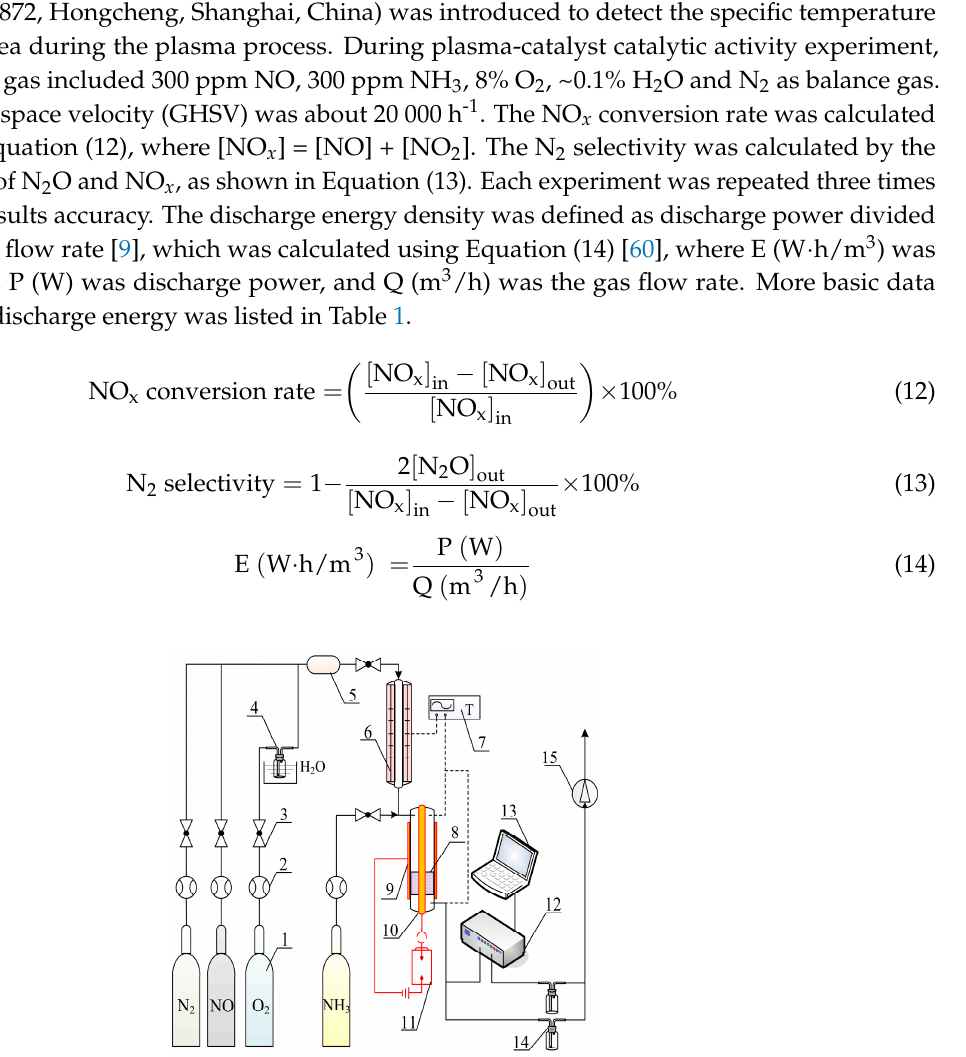
Figure 10. The schematic diagram about the catalyst-plasma hybrid system. 1, standard gas; 2, mass flowmeter; 3, shutdown valve; 4, water carrier; 5, gas mixer; 6, resistance furnace; 7, temperature controller; 8, nanocatalysts; 9, ground electrode; 10, high voltage electrode; 11, AC power transverter; 12, flue gas analyzer; 13, record system; 14, gas washing bottle; and 15, induced draft